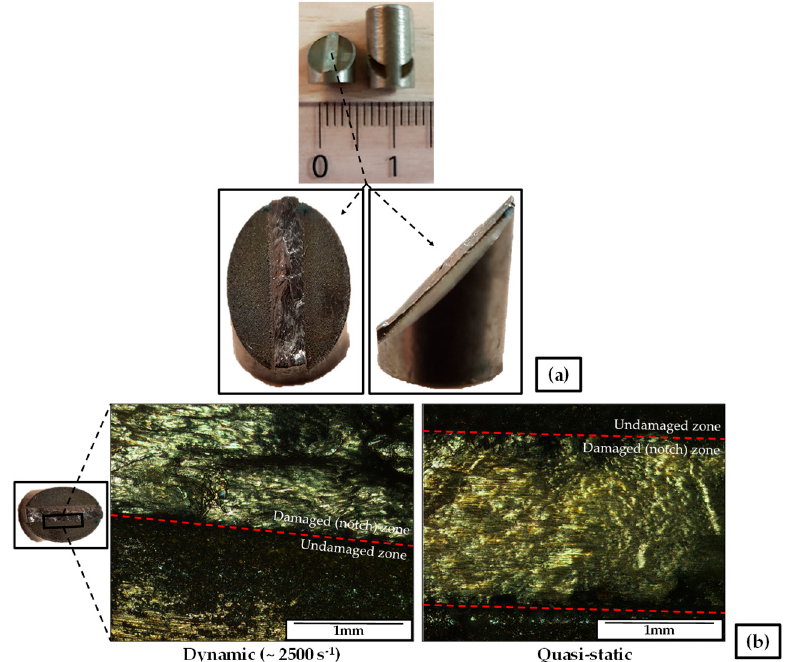
Figure 14. ( a ) Closer view on the notch section of a dynamic-loaded sample (CSA02), ×10 macro lens. ( b ) Fractographies of notch surfaces, ×5 lens magnification.